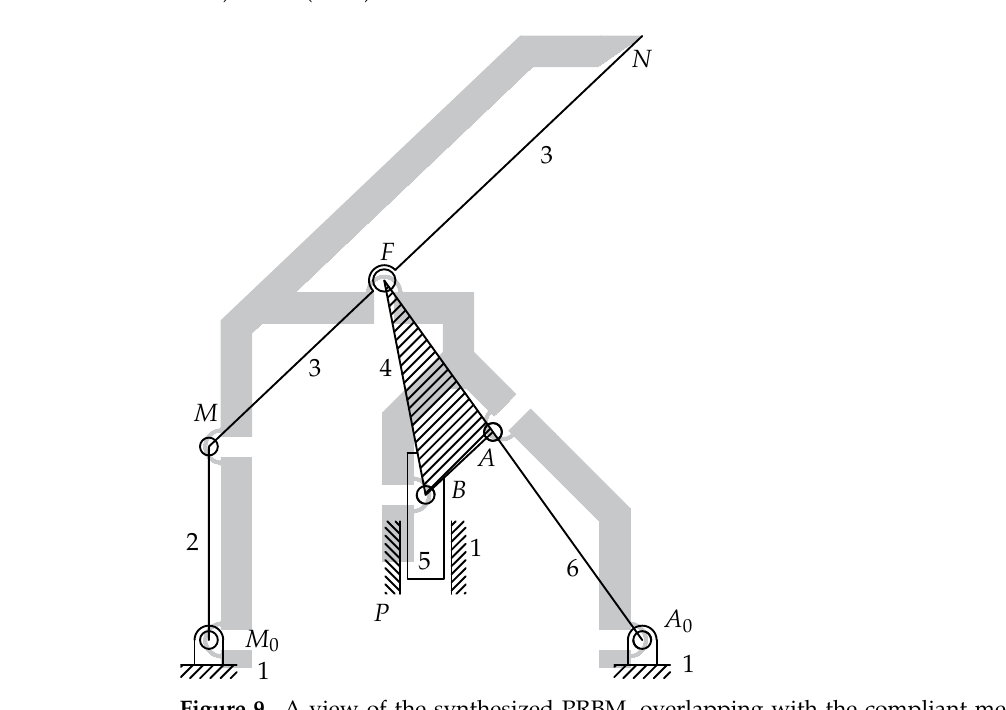
Figure 9. A view of the synthesized PRBM, overlapping with the compliant mechanism that is obtained after the joint replacement